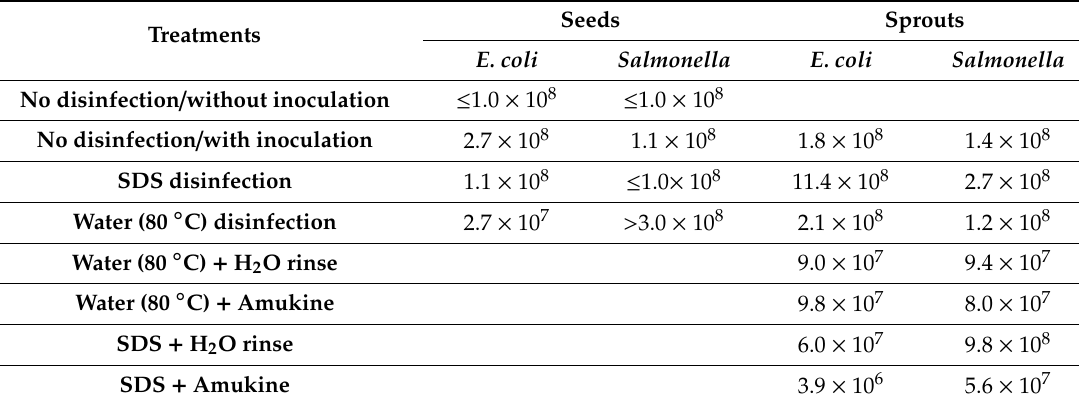
Table 3. Microbial counting after disinfection treatments (UFC / mL) of lentil seeds and sprouts. Seeds Treatments